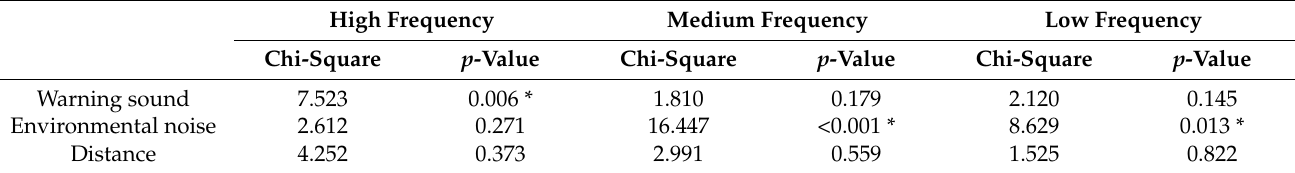
Table 2. Kruskal–Wallis test results for detection rate with high-, medium-, and low-frequency warning sounds.